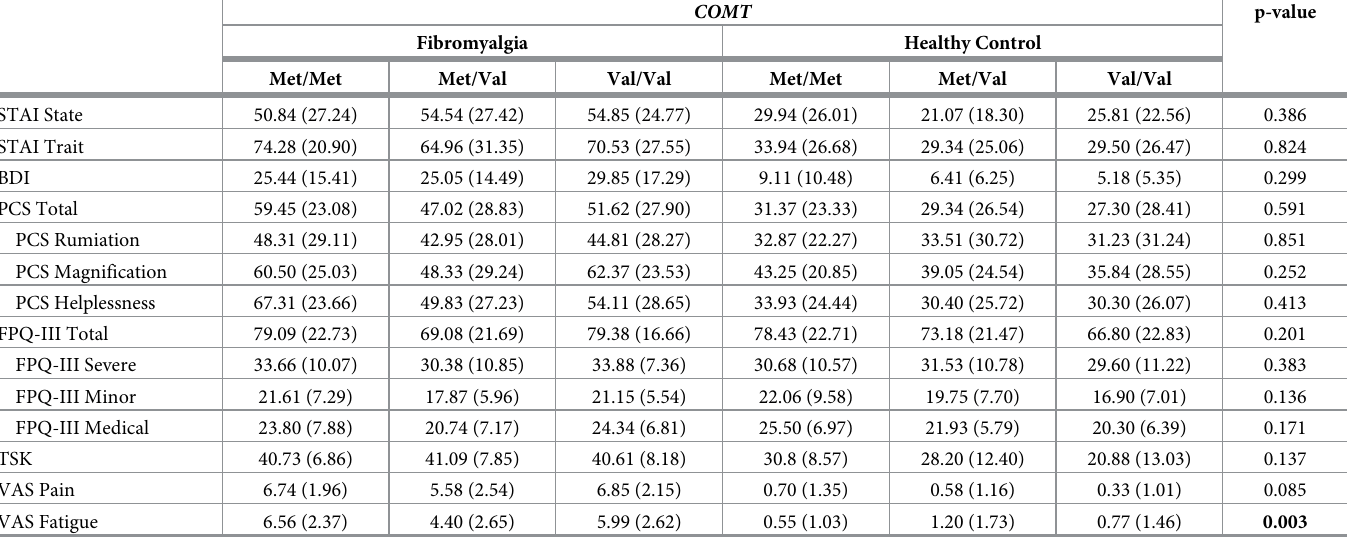
Table 3. Mean scores and standard deviations (in parenthesis) of clinical measures. Data are separated by group (fibromyalgia and healthy control) and genotypes (Val/Val, Met/Val and Met/Met). P-values for the interaction effects between COMT x Group were also